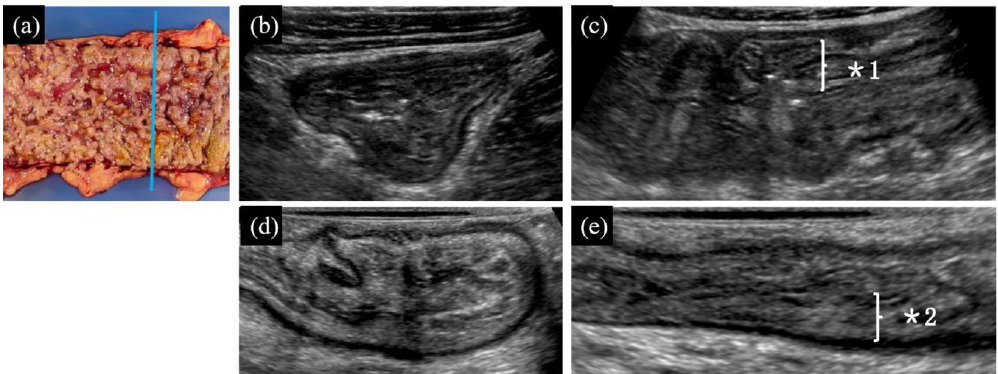
Figure 3. Cobblestone-like appearance in hepatic flexure of the ascending colon. Cobblestone-like appearance, which is a specific characteristic of CD, indicates longitudinal and circumferential fissures and ulcers on separate islands of mucosa, giving it an appearance reminiscent of cobblestones. ( a ) Gross morphology findings from open view. The blue line shows the scanning line of the transverse view. Note the sharp demarcation between the cobblestone mucosa of the involved segment and the grossly colonic mucosa. ( b , c ) From transverse ( b ) and longitudinal ( c ) views by TAUS, the appearance of the serosa and the muscular layer of the intestinal wall is observed. However, stratification of the mucosal and submucosal layers is indistinct ( ＊ 1). The hyperechoic submucosal layer shows heterogeneous thickening. The mucous surface is irregular in appearance. Hyperechoic adipose tissue is present around the intestine. No fistula signs are detected. ( d,e ) Transverse ( d ) and longitudinal ( e ) views of the intestinal section by WIUS (closed view). The images show that the mucosal layer is blurred while the submucosal layer is heterogeneous by echogenicity with an uneven thickness ( ＊ 2). The serous and muscular layers are clearly displayed with normal thicknesses. The mucous surface is irregular in appearance. There is hyperechoic adipose tissue around the intestine wall with mild hypertrophy. The continuity of the intestinal wall is good, and there is no interruption in the serous layer or the formation of hypoechoic fistulae. For this lesion, TAUS and WIUS were consistent in determining the following US parameters: (1) indistinct presence of submucosal and mucosal layers; (2) thickening of the submucosal layer; (3) irregularity of the mucous surface; (4) increased fat wrapping around the bowel wall; and (5) absence of fistula signs.